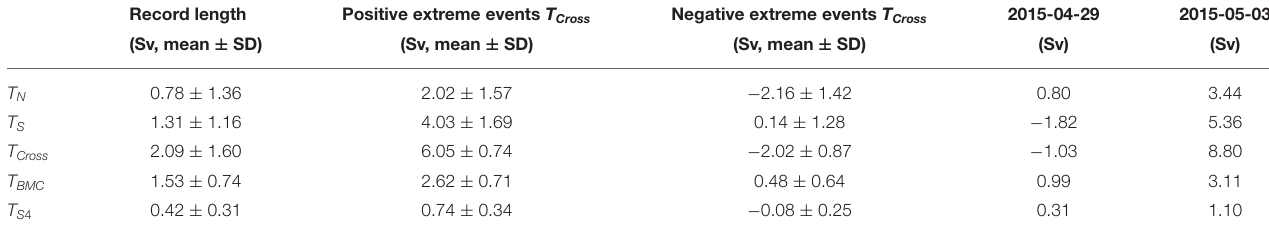
TABLE 3 | Mean transport (Sv) through selected sections for the entire model run (1993–2018), during extreme cross-shore transport events, and during the large transport reversal observed in early May 2015 (see section 4.4). Record